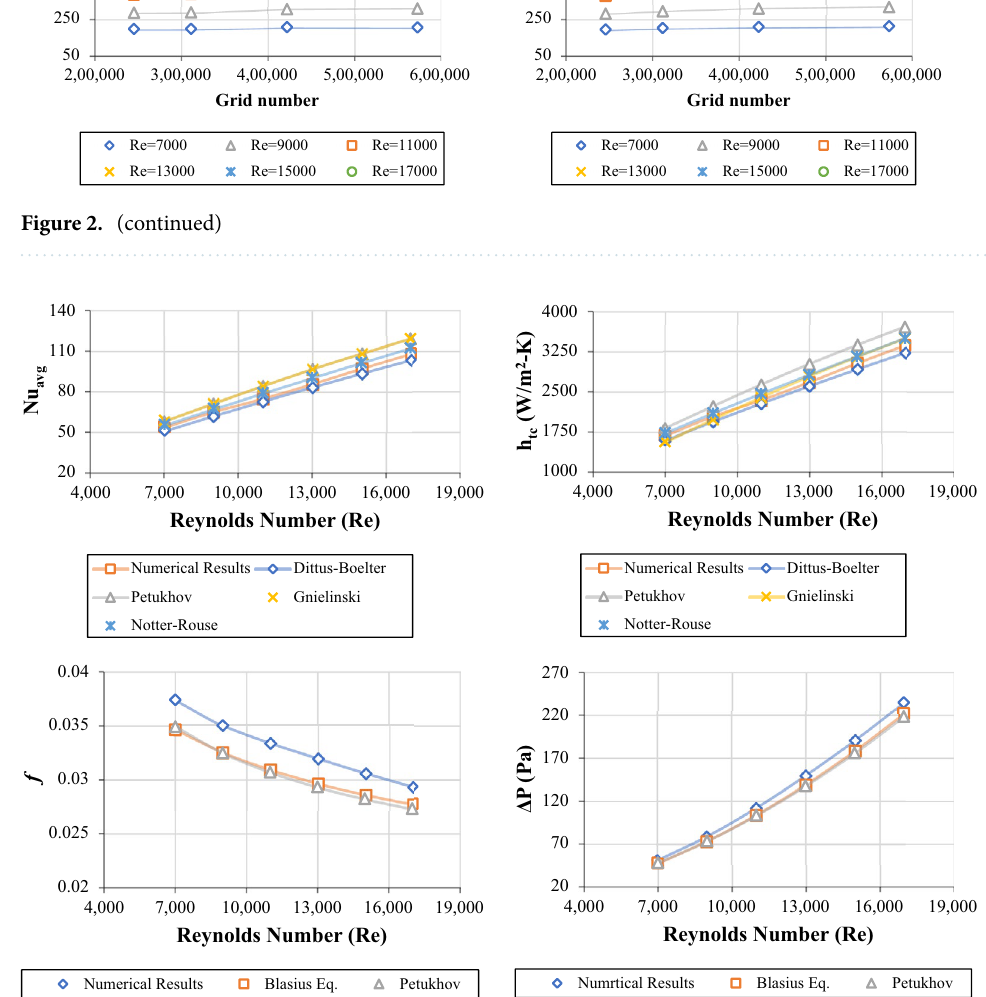
Figure 3. Heat transfer and fluid flow properties of DW at different Reynolds numbers using numerical calculations and empirical